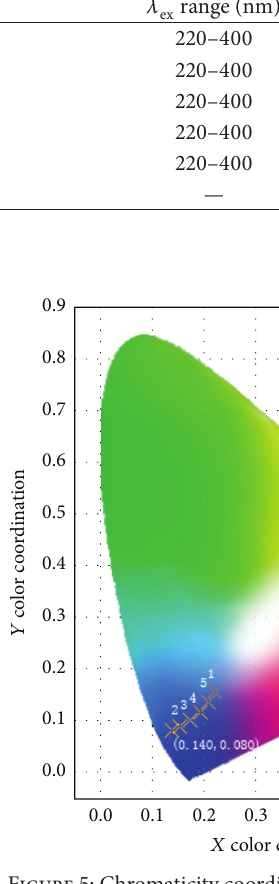
Figure 4: Photoluminescence decay curves of Ce 3+ in Sr 3−𝑥 B 2 SiO 8 : 𝑥 Ce 3+ ( 𝑥 = 0.0025 ∼ 0.05) phosphors.